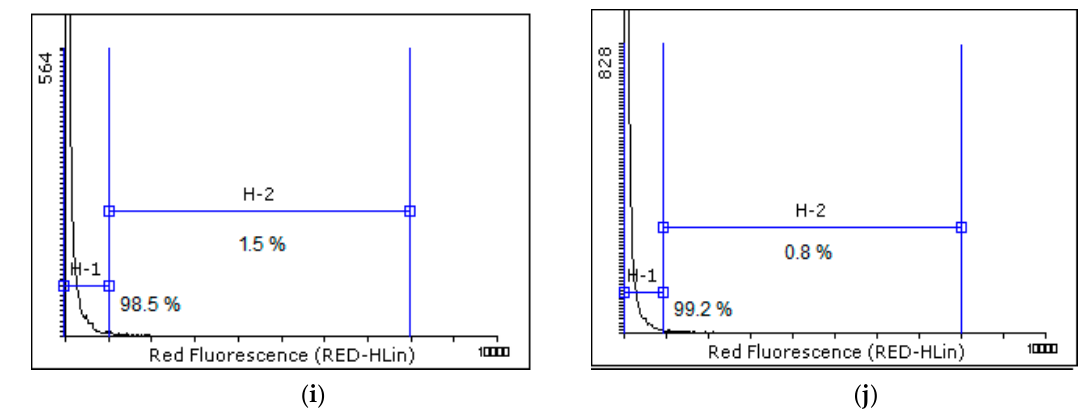
Figure 7. Analysis of viability determined by flow cytometry for PI-stained selected fungal isolates. ( a ) C. albicans from polyurethane foam. ( b ) C. subhashii from polyurethane foam. ( c ) C. albicans from Bialecki ring (25 × 25). ( d ) C. subhashii from Bialecki ring (25 × 25). ( e ) C. albicans from Pall ring. ( f ) C. subhashii from Pall ring. ( g ) C. albicans from Bialecki ring (50 × 50). ( h ) C. subhashii from Bialecki ring (50 × 50). The regions H-2 indicated by the bars represent the percentage of fungi with permeable membranes, whereas H-1 are living cells. ( i ) C. albicans —control with cells not immobilized. ( j ) C. subhashii —control with cells not immobilized.